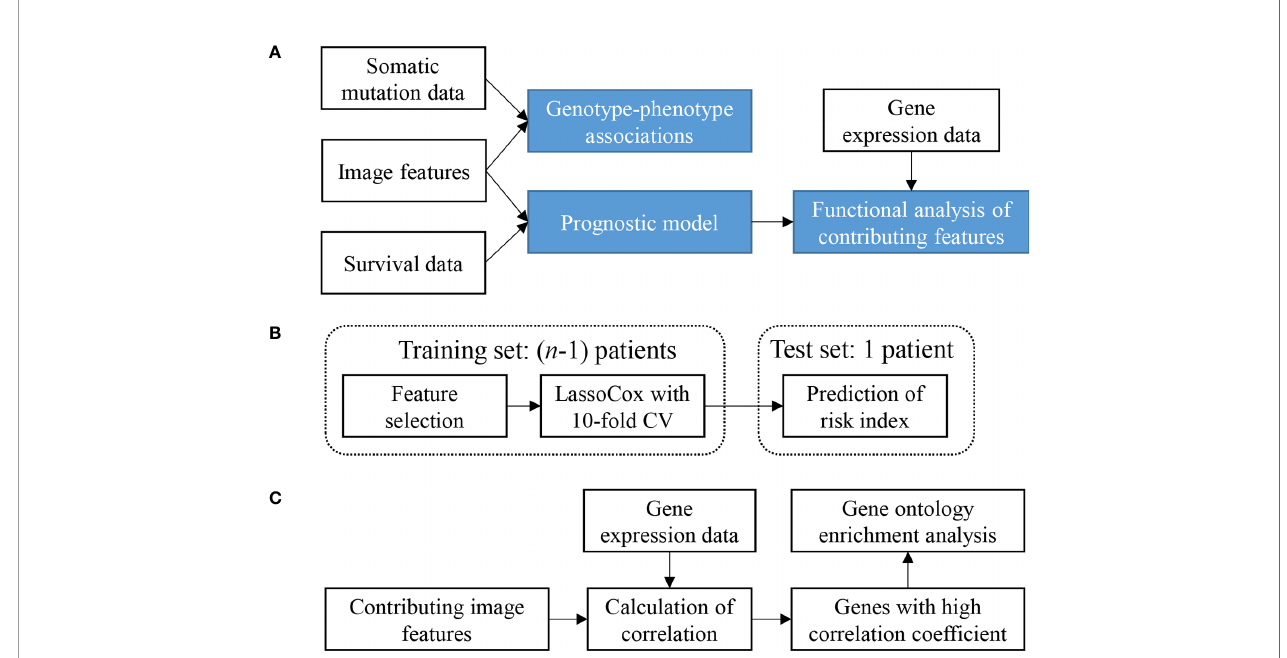
FIGURE 1 | Study design and analysis overview. (A) Analysis work fl ow depicting the overall study design. (B) Cross validation scheme showing one round of leave- one-out cross validation. n is the sample size. CV, cross-validation. (C) Scheme of the gene functional enrichment analysis of genes that correlated with the contributing features that were frequently selected in the process of leave-one-out cross